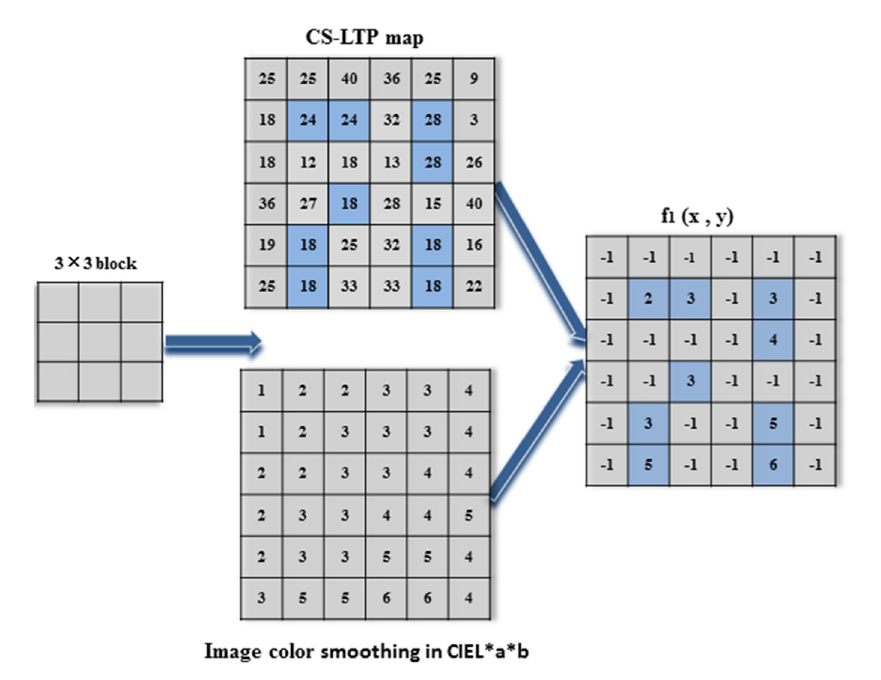
block from left to right and